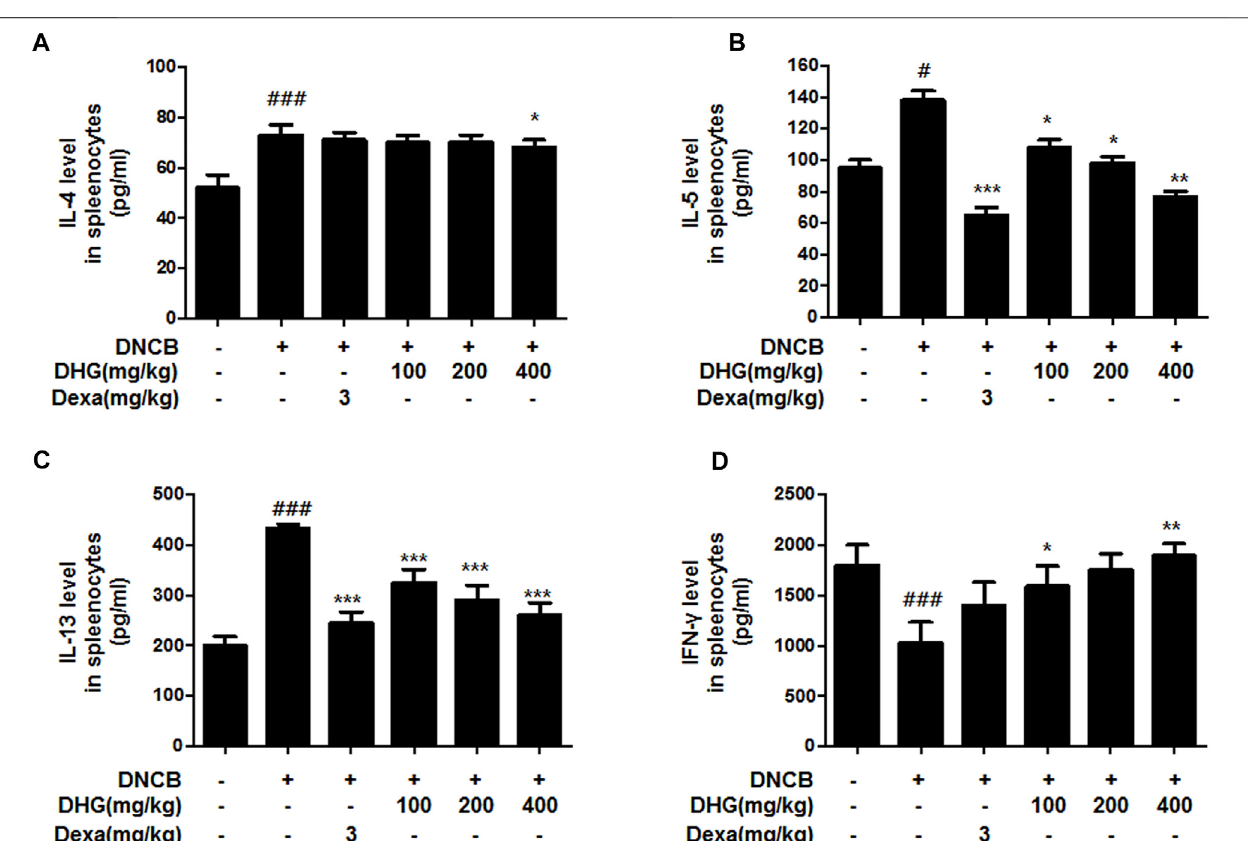
Frontiers in Pharmacology |